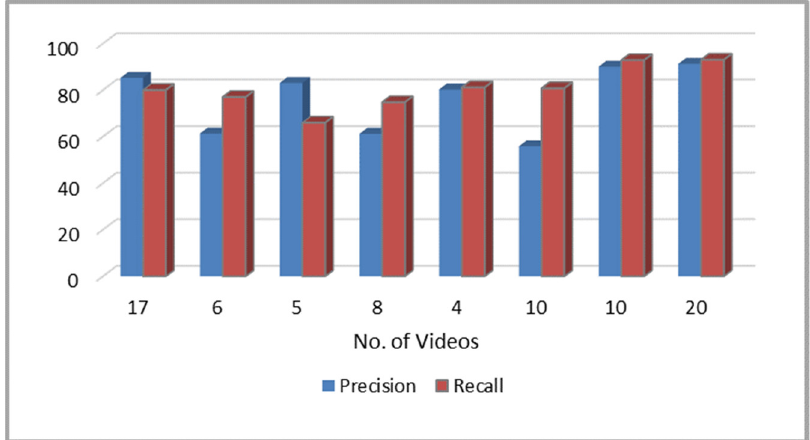
Figure 11. Comparison graph of the proposed method with state of the art. Table 3. Performance comparison of the proposed method with existing techniques.